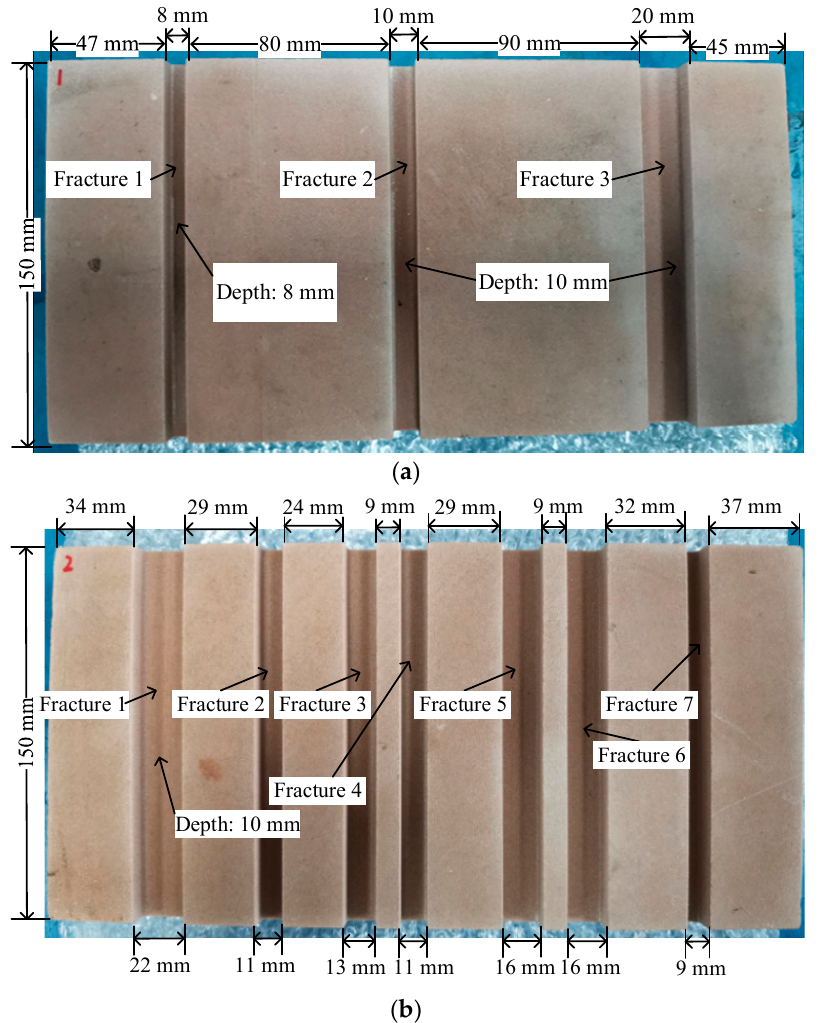
Figure 7. Reflector samples. ( a ) Grooved sandstone Plate 1 and ( b ) Grooved sandstone Plate 2.